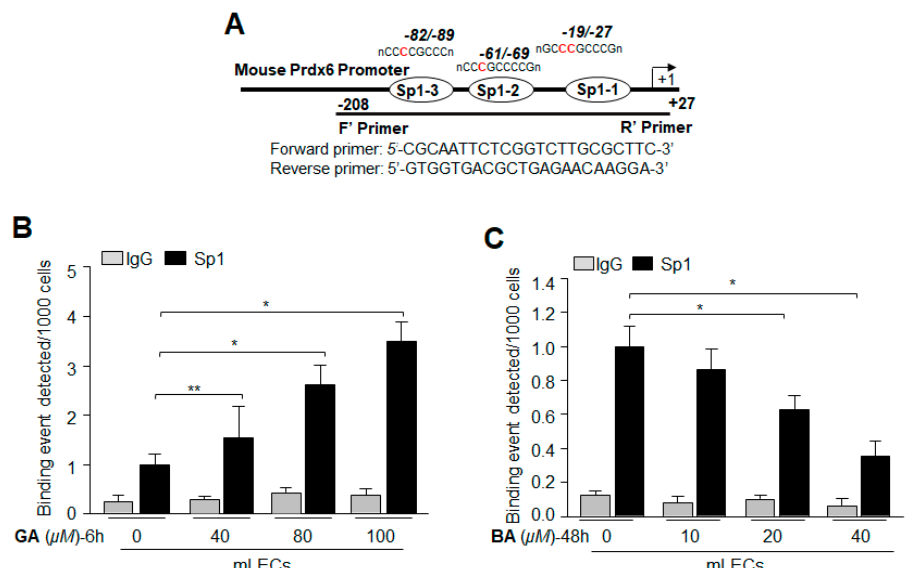
Figure 8. Treatment with Sumoylation inhibitor GA enhanced Sp1–DNA binding, while Sumoylation agonist BA reduced binding activity. ( A ) Digramatic illustration of 5 ′ -proximal promoter region of Prdx6 containing Sp1 binding sites showing primer location and sequences used in ChIP assay. LECs were treated with three different concentrations of GA ( B ) for 6 h or BA ( C ) for 48 h as shown. Chromatin immunoprecipitation assay was carried out with an anti-Sp1 antibody (black bars) and control IgG (gray bars). Pulled DNA fragments were subjected to a qPCR analysis for Sp1 binding site(s) of Prdx6 promoter. GA significantly enhanced the Sp1-DNA enrichment in concentration-dependent fashion. In contrast, BA reduced the Sp1-DNA availability to Sp1 response elements present in Prdx6 promoter. The data represent the mean ± SD from three independent experiments (** p < 0.05; * p < 0.001).